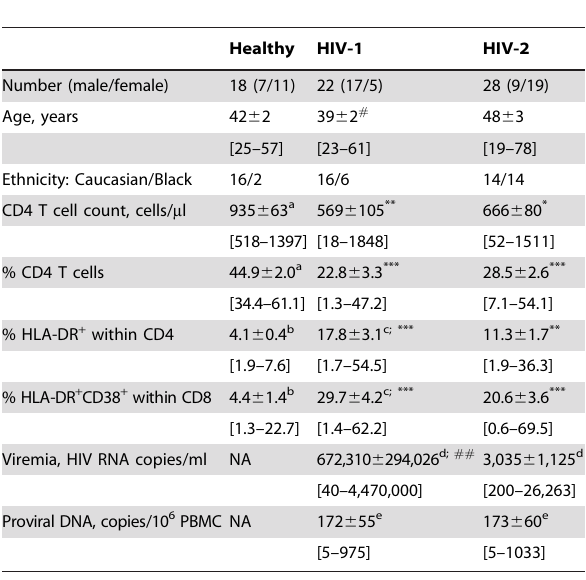
Table 1. Characteristics of the cohorts studied.